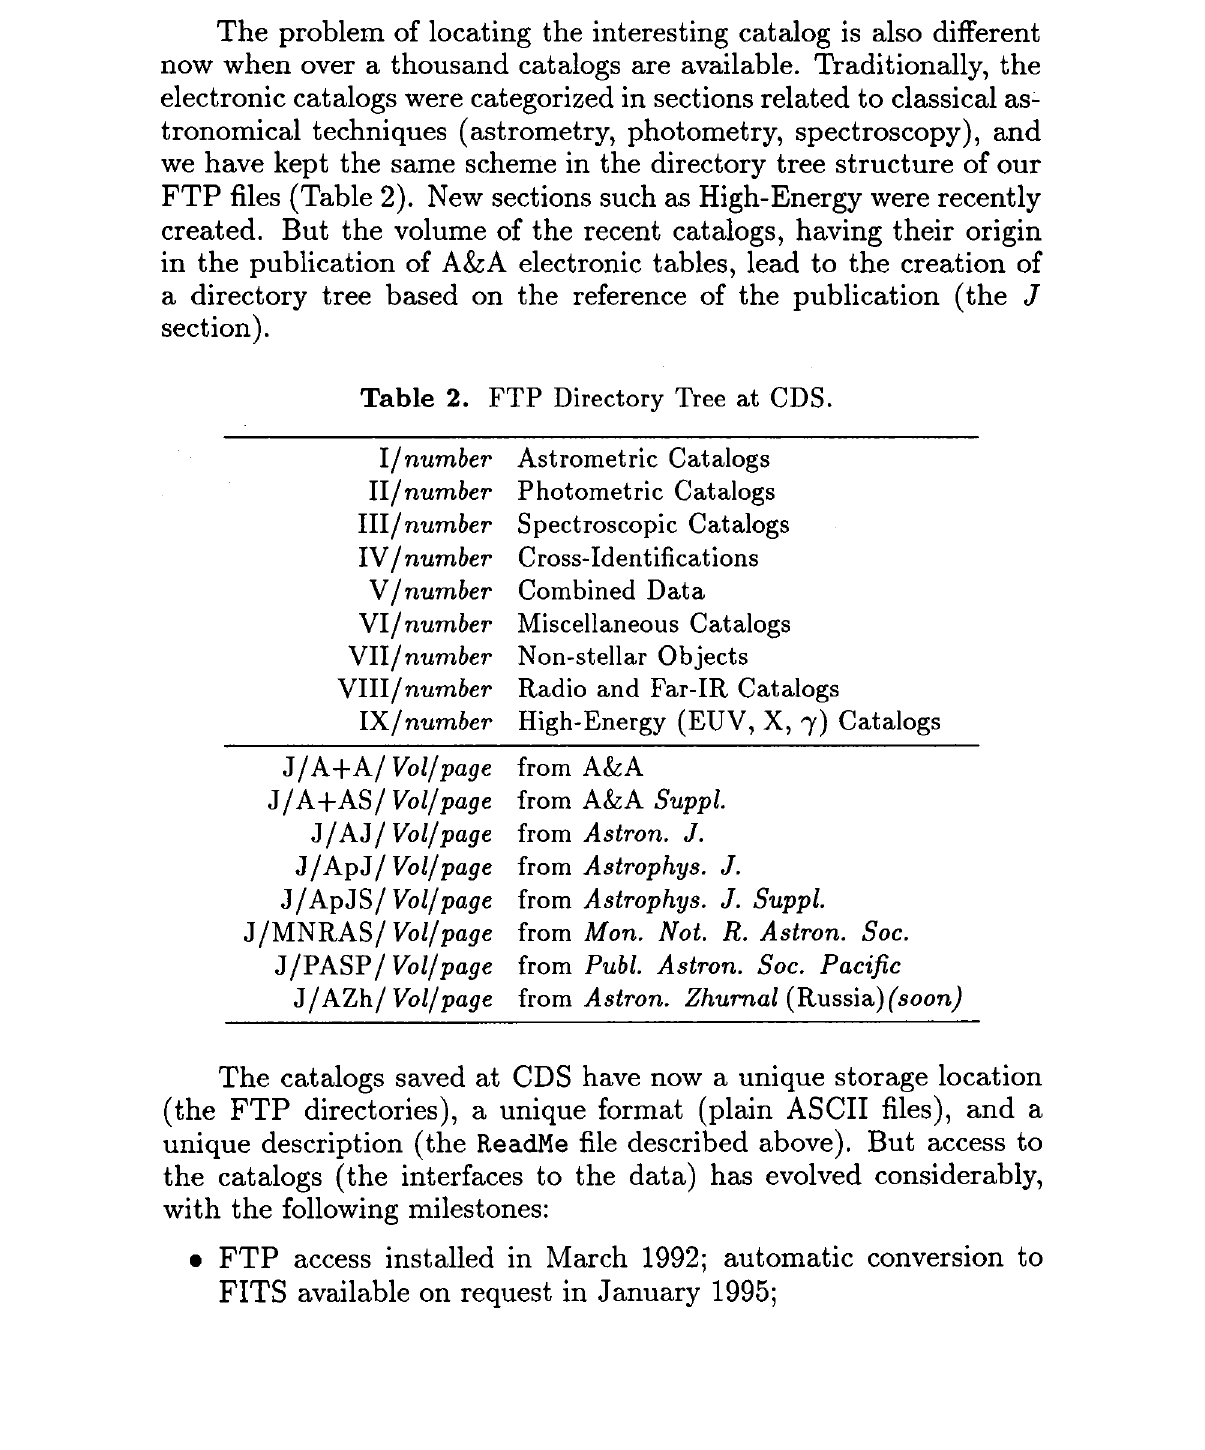
Table 2. FTP Directory Tree at